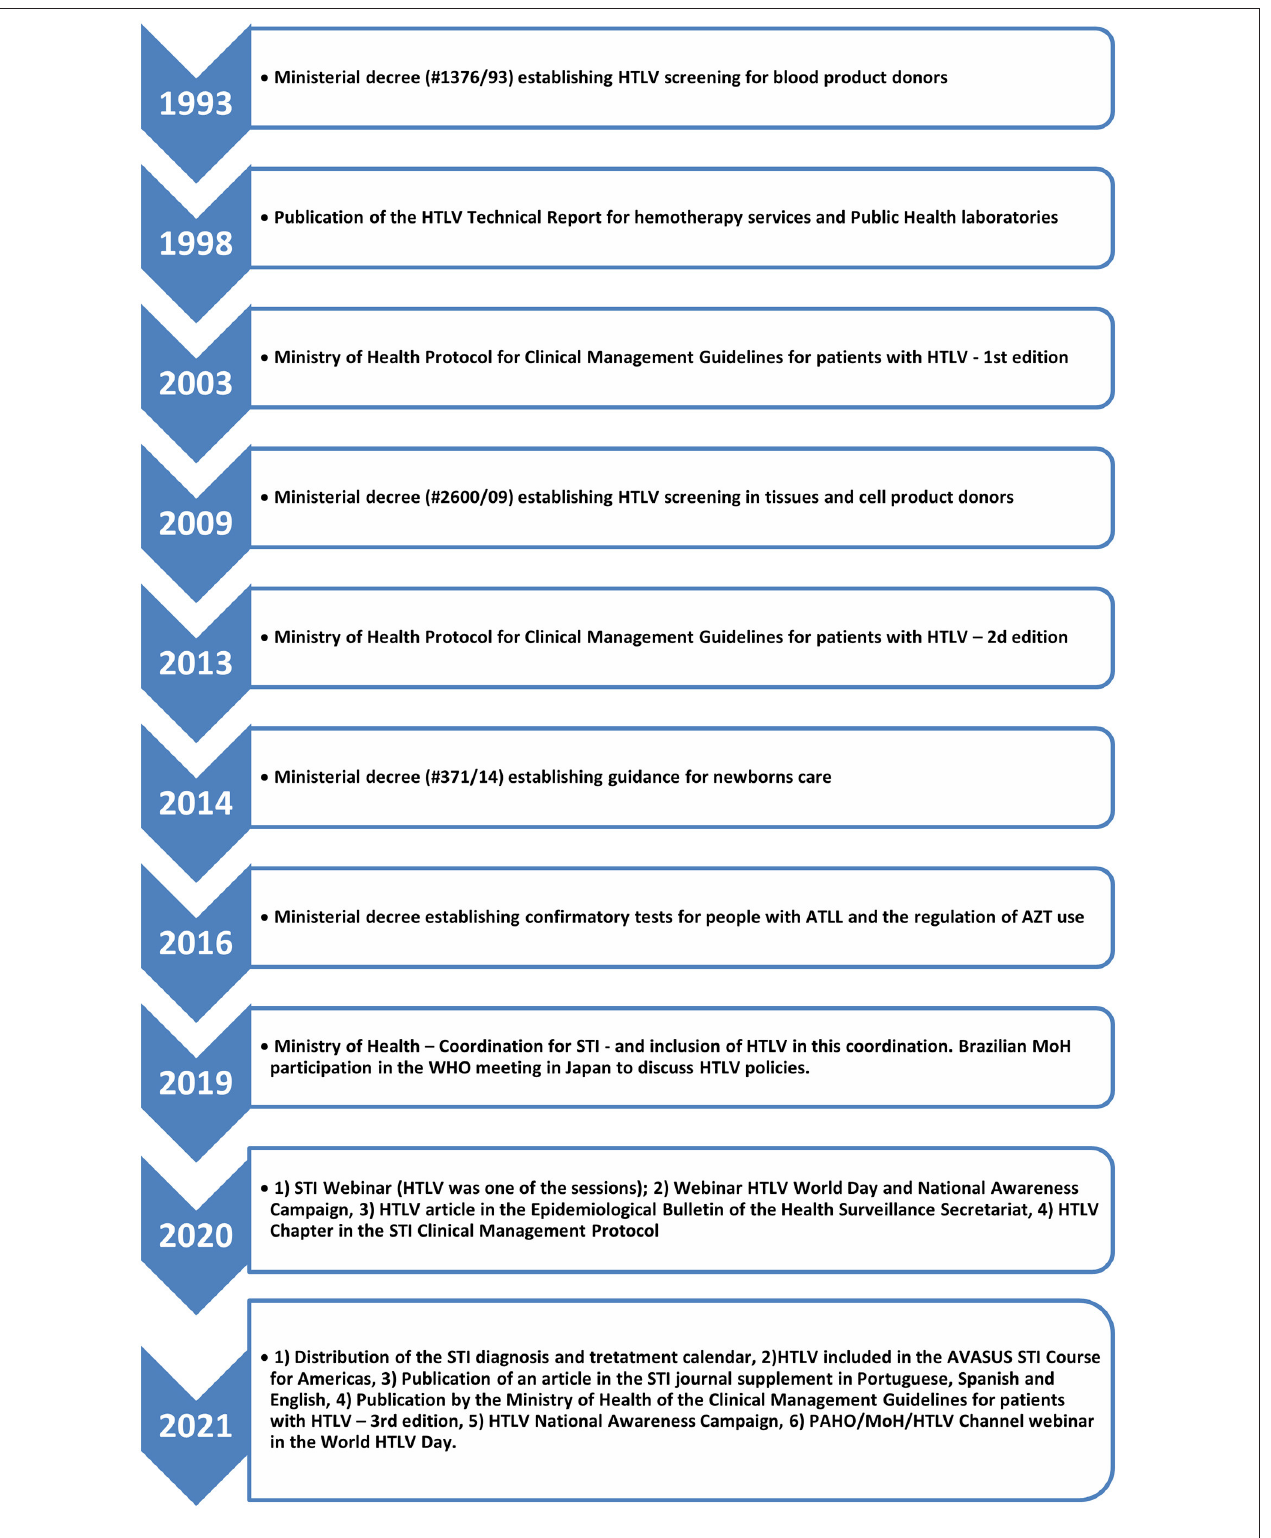
FIGURE 2 | Timeline of the implementation of public policies for HTLV control in Brazil.